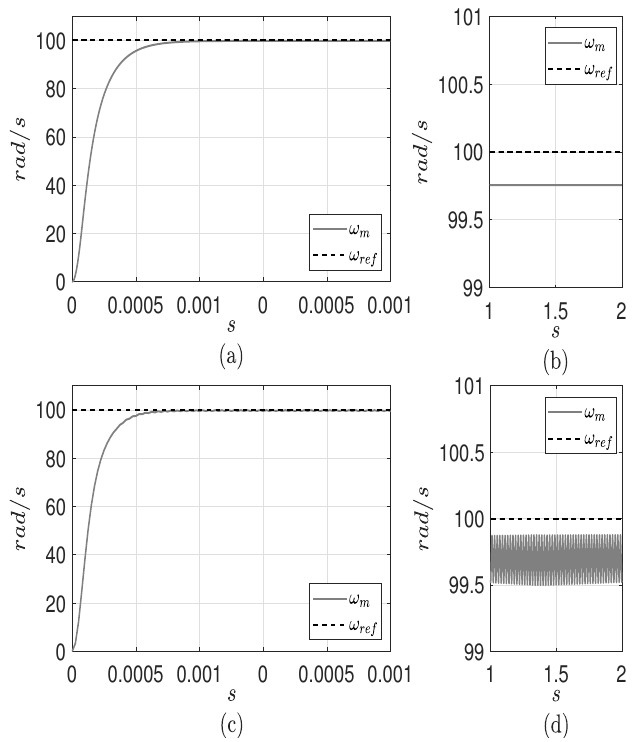
Figure 6. ω ref (dashed line), ω m (gray line) ( a ) Performance of the controller motor applied to a sinusoidal BLDC motor. ( c ) Performance of the controller applied to a non-sinusoidal BLDC motor. ( b , d ) Zoom of the figures on the left. Table 2. Precision error and chattering for sinusoidal and trapezoidal back-EMF